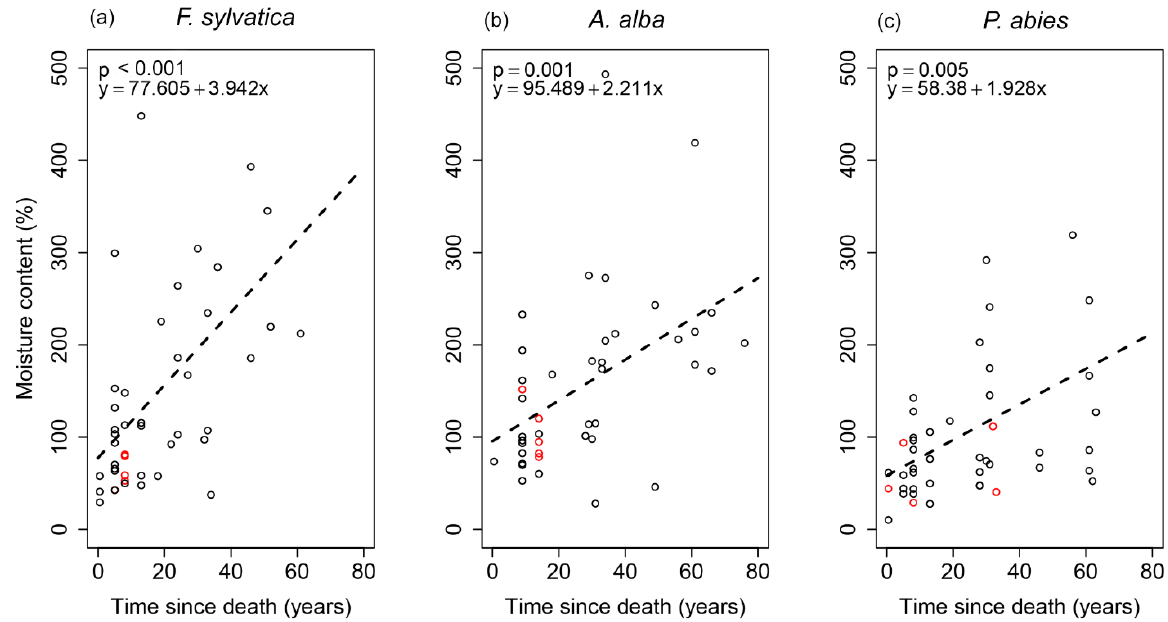
Figure 3. Linear regression models between the moisture content and time since death for each tree species: ( a ) F. sylvatica ; ( b ) A. alba ; ( c ) P. abies . Red circles—logs without ground contact.